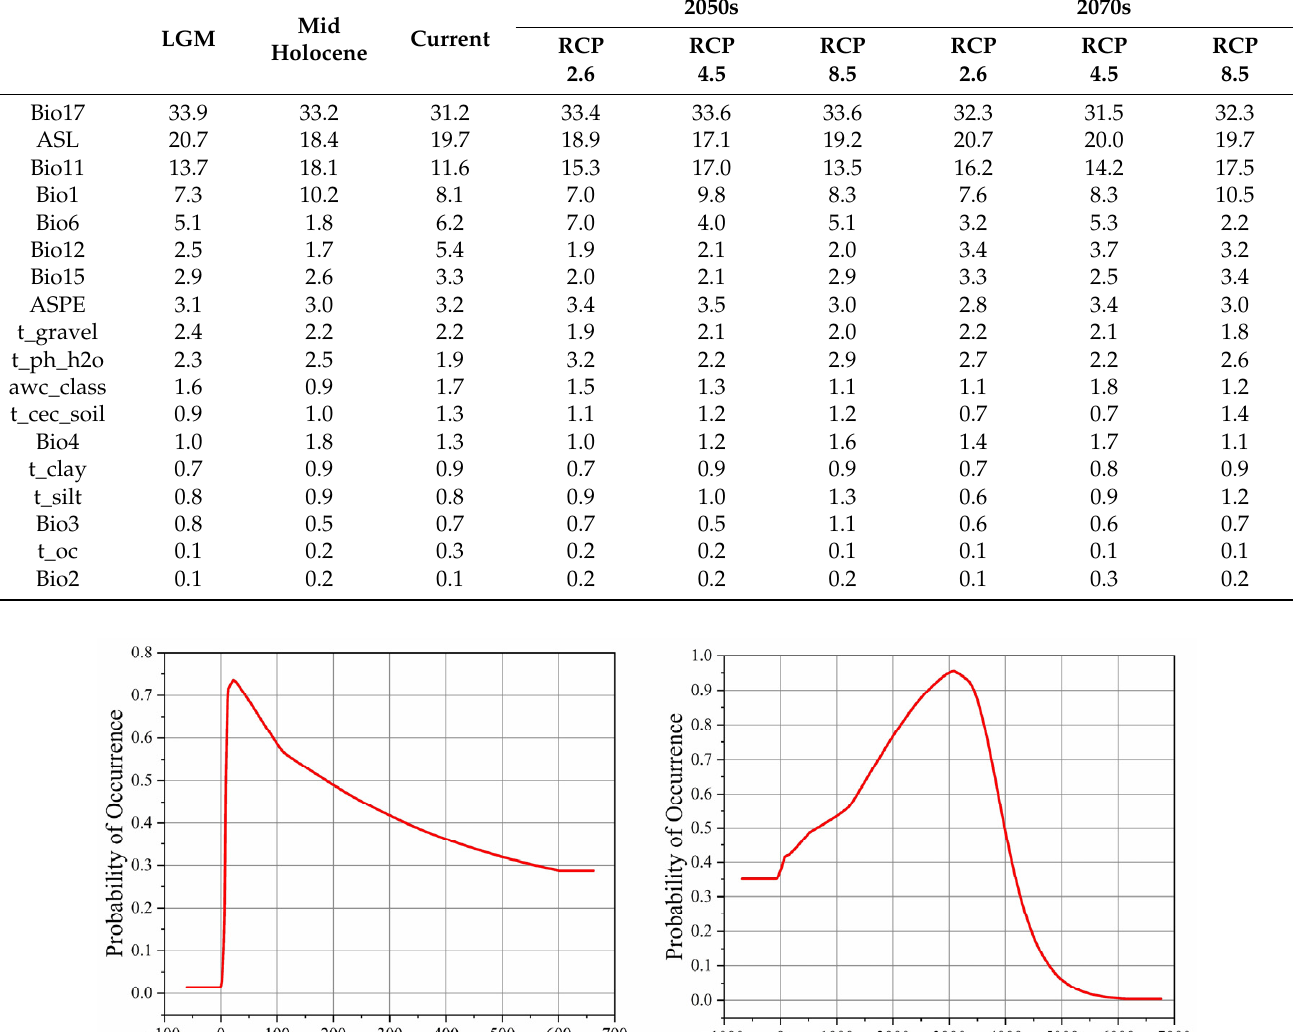
Table 3. Percentage of environmental variables using the Jackknife method in different periods.